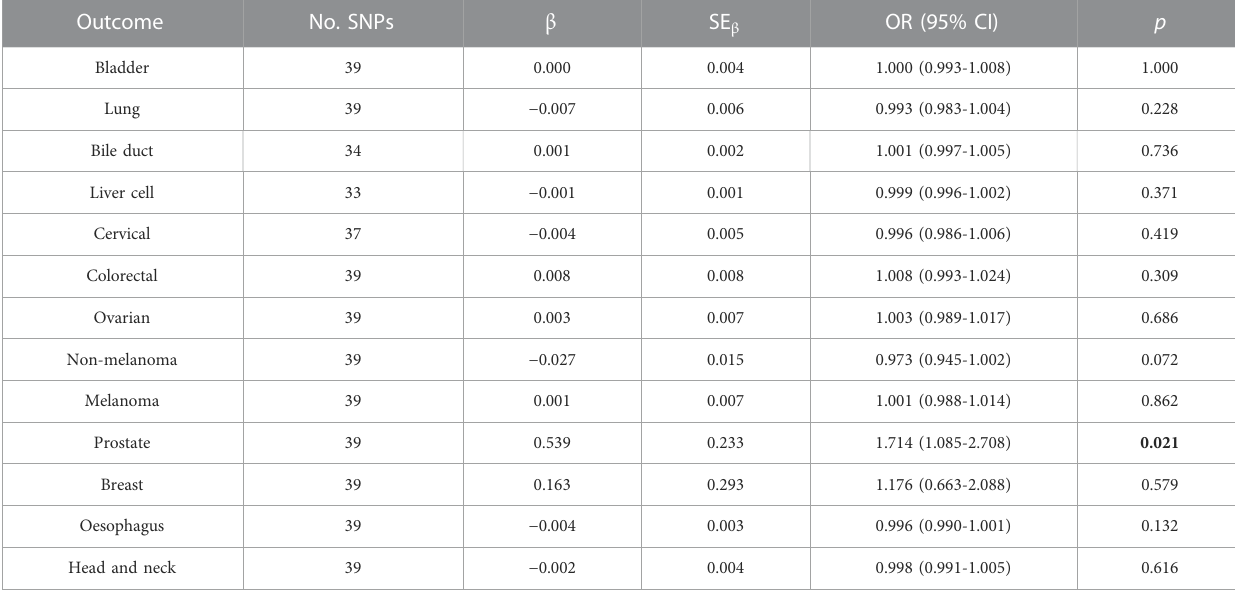
TABLE 3 Two sample MR analysis results of simvastatin use and pan-cancer via Fixed-effect inverse variance weighted (IVW EF ) method.